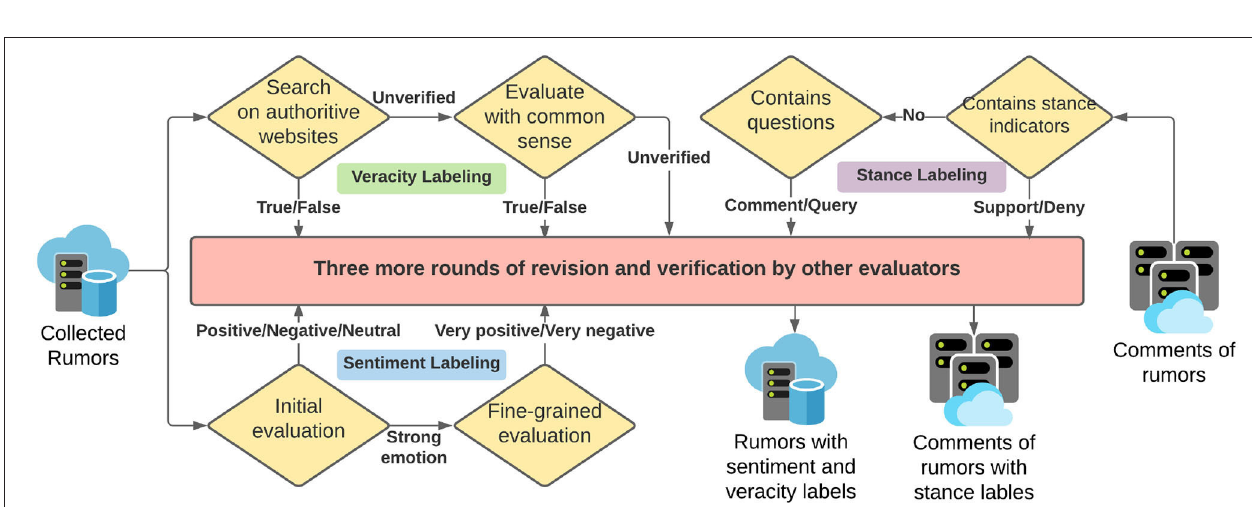
would be rated as unverified if it does not violate the common sense